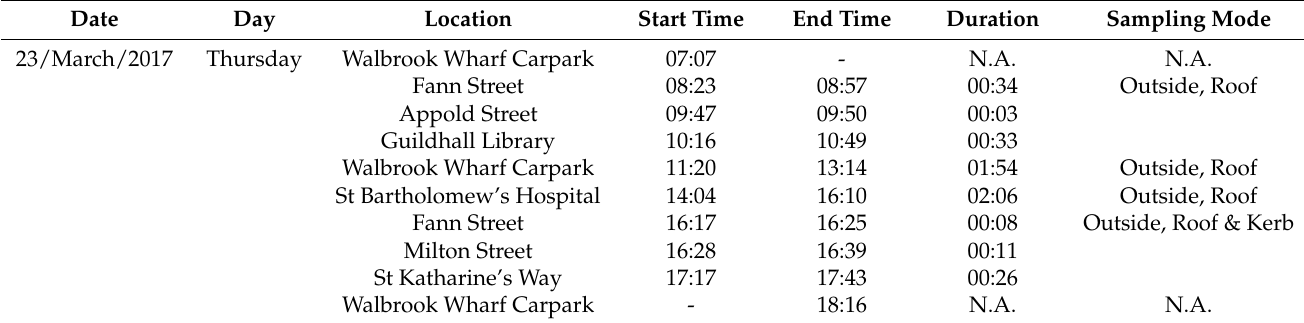
Table 1. Example of a one-day Smogmobile Air Quality measurement Time and Location